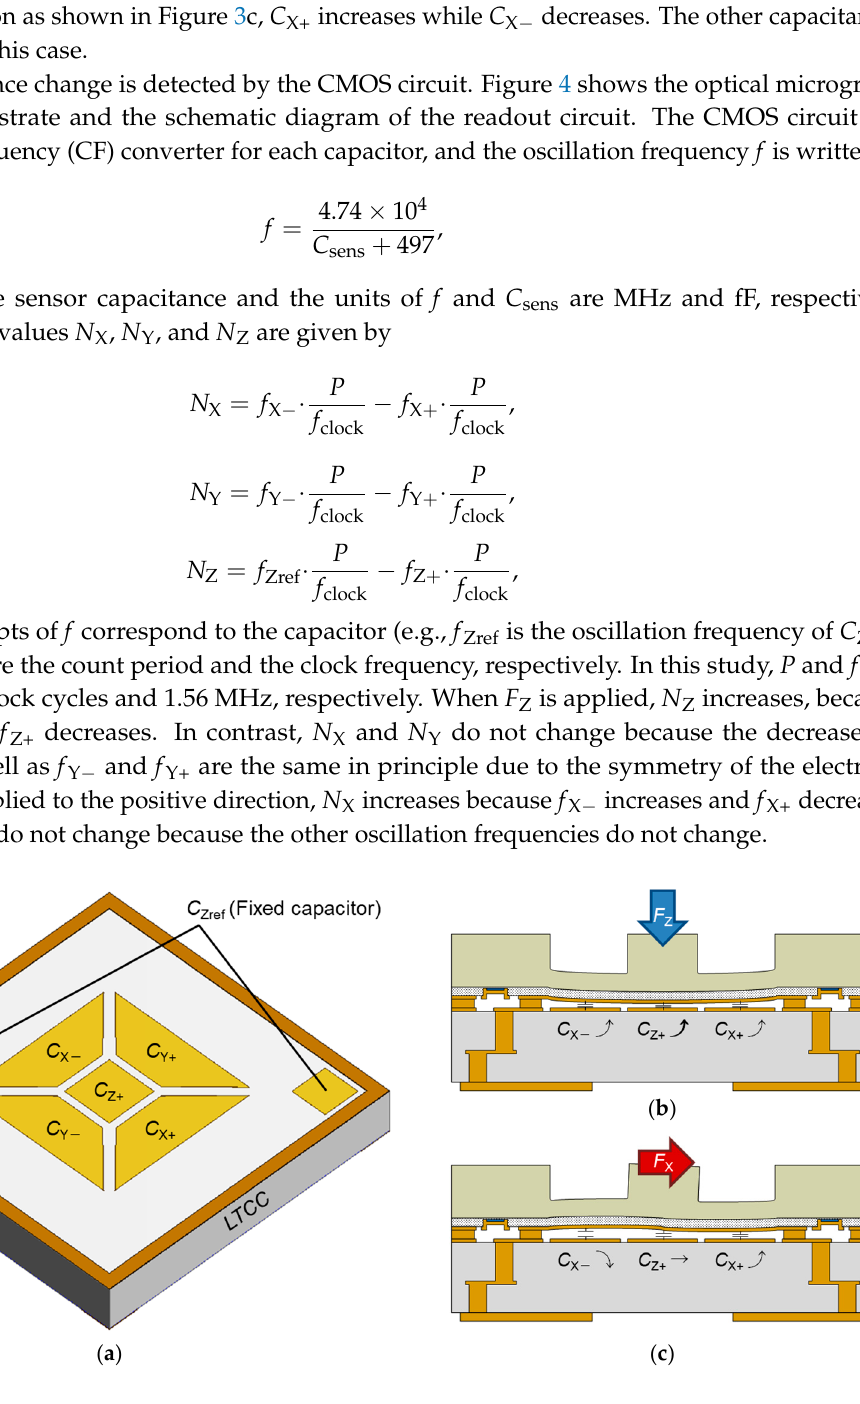
Figure 3. ( a ) Electrode layout; Working principles for ( b ) normal force F Z and ( c ) X-axis shear force F X .